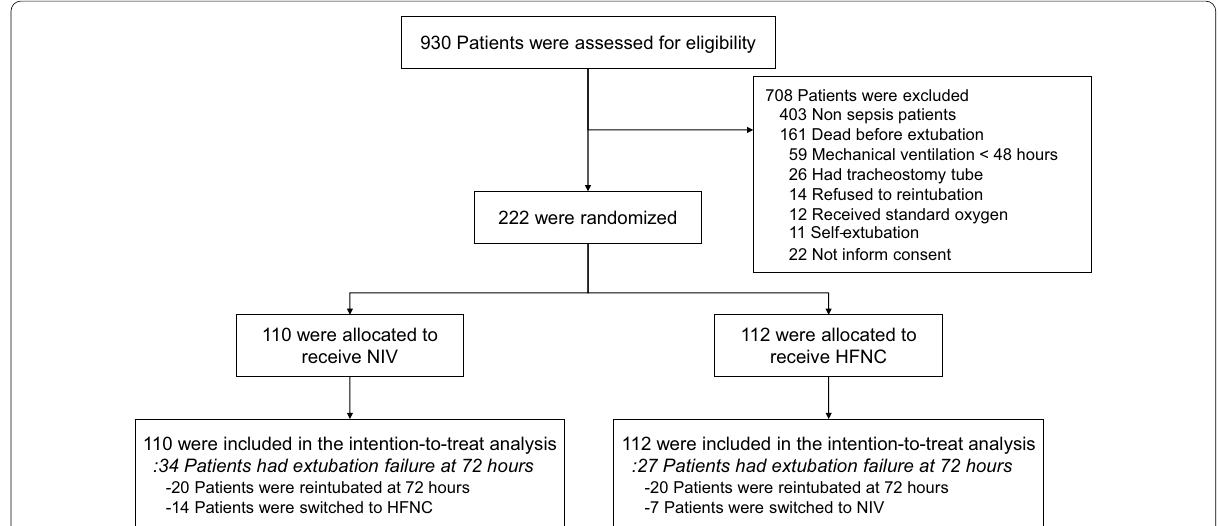
Fig. 1 Flow diagram illustrating the screening, enrolment, and randomisation of patients HFNC: High-flow nasal oxygen cannula; NIV: noninvasive mechanical